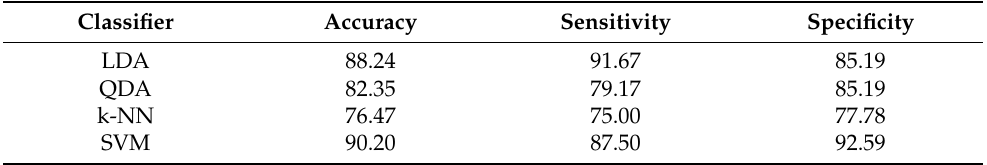
Table 2. Comparison of classification performance among LDA, QDA, k-NN, and SVM classifiers using KERP feature (in